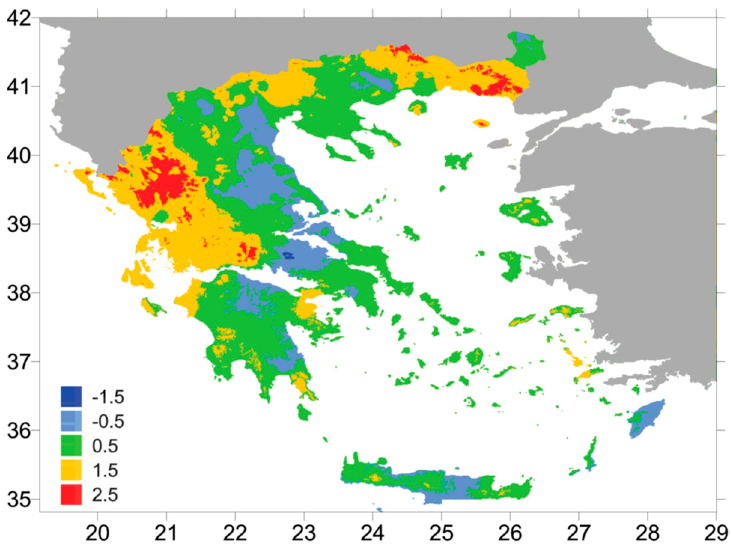
Figure 6. Map of the differences between the gridded δ 18 O data for springs and precipitation.